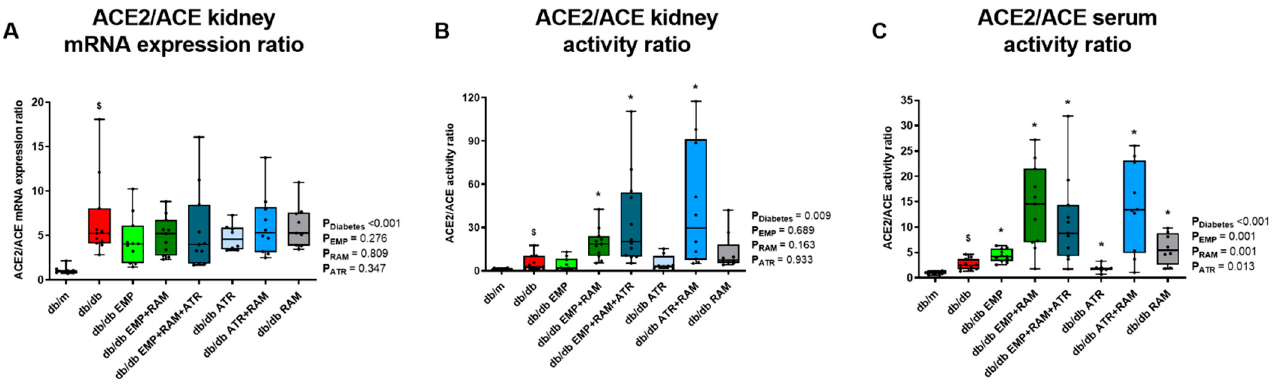
Figure 6. Kidney ACE2/ACE mRNA expression and enzymatic activity ratio. ( A ) ACE2/ACE mRNA expression ratio. ( B ) ACE2/ACE kidney activity ratio. ( C ) ACE2/ACE serum activity ratio. db/m : non-diabetic mice treated with vehicle. db/db : diabetic mice treated with vehicle. db/db EMP : diabetic mice treated with empagliflozin. db/db EMP + RAM : diabetic mice treated with empagliflozin and ramipril. db/db EMP + RAM + ATR : diabetic mice treated with empagliflozin, ramipril, and atrasentan. db/db ATR : diabetic mice treated with atrasentan. db/db ATR + RAM : diabetic mice treated with atrasentan and ramipril. db/db RAM : diabetic mice treated with ramipril. Factorial ANOVA main effect results are displayed next to the graph. P Diabetes : diabetes’ main effect. P EMP : empagliflozin’s main effect. P RAM : ramipril’s main effect. P ATR : atrasentan’s main effect. $ p < 0.05 vehicle-treated db/db mice vs. vehicle-treated db/m mice. * p < 0.05 any treated db/db mice compared with vehicle-treated db/db